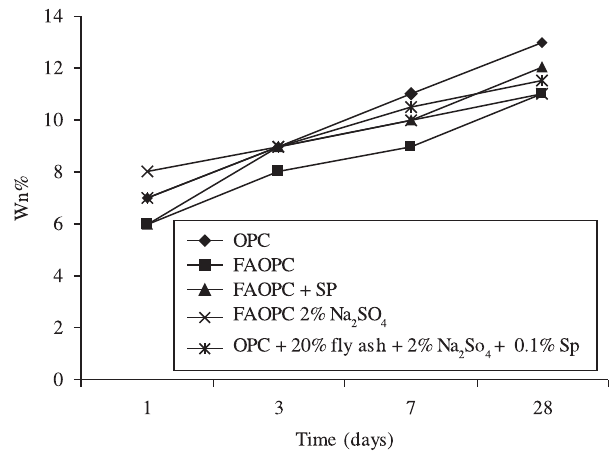
Figure 4. Variation of non – evaporable water content with hydration